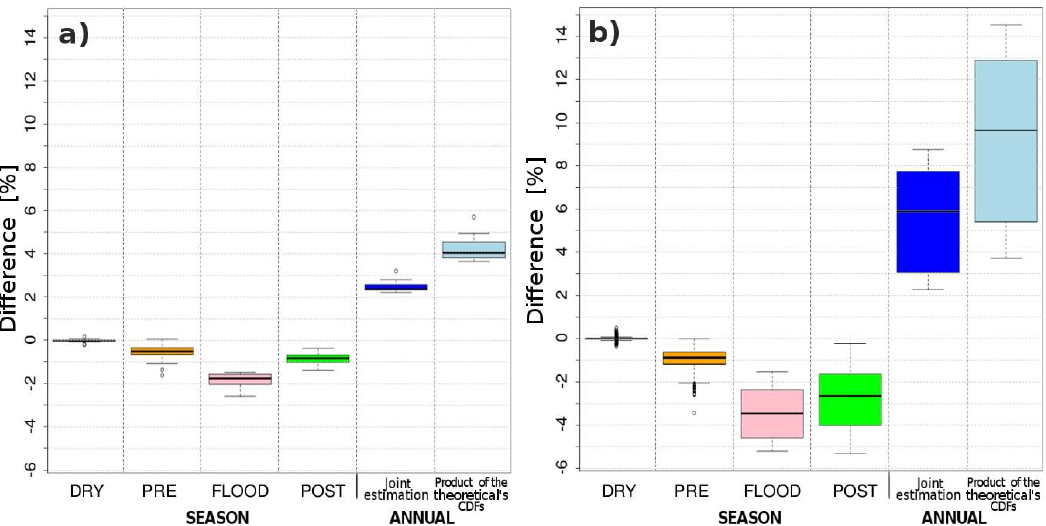
Fig. 5. Sensitivity of the proposed approach to the duration of and dependence among seasons (independent seasons, panel (a) ; significant correlation between flood and post-flood season, panel (b) ; see Sect. 4.3): relative differences (%) between the 100-yr peak flows estimated independently through a maximum likelihood estimator, or retrieved from jointly estimated seasonal CDFs by adopting uniform weights (proposed technique); the two boxplots for the ANNUAL case present the comparison between the 100-yr flood estimated at annual time- scale through a maximum likelihood estimator and the corresponding estimates retrieved from CDFs obtained as the product of jointly estimated seasonal CDFs (proposed approach – blue boxplot), or the product of independently estimated seasonal CDFs (light blue